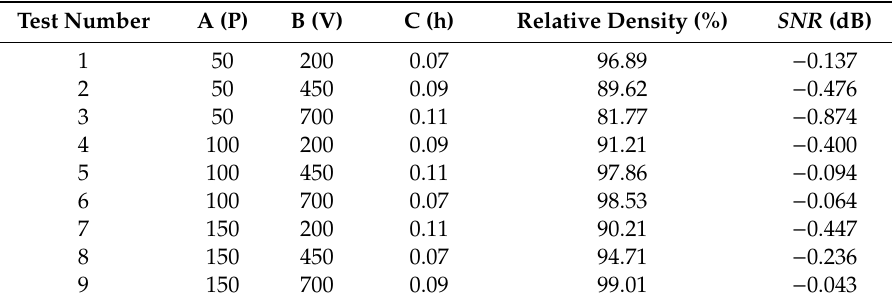
Table 2. Experimental design and results of